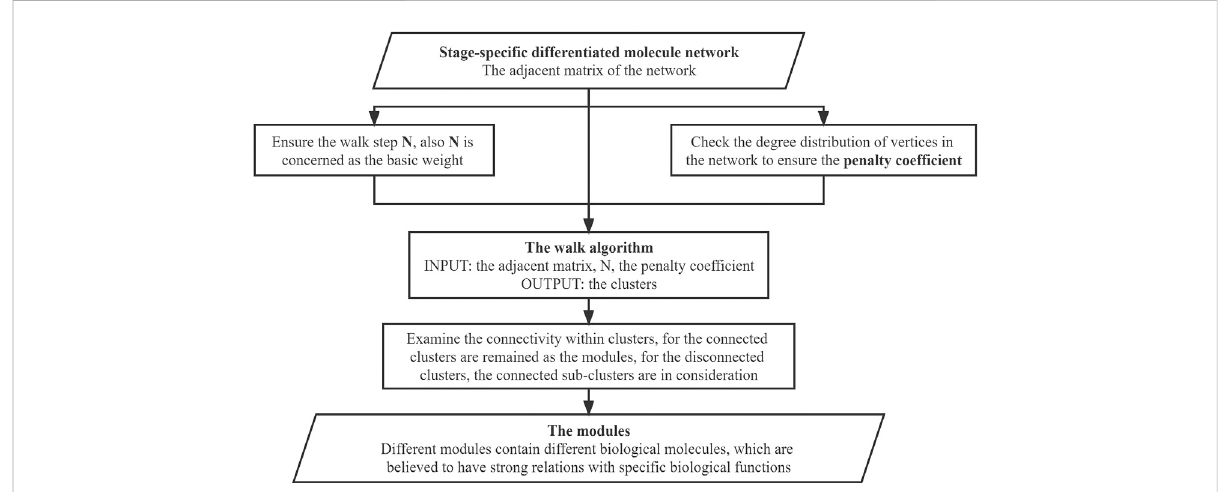
FIGURE 5 Flowchart for the module identi fi cation.